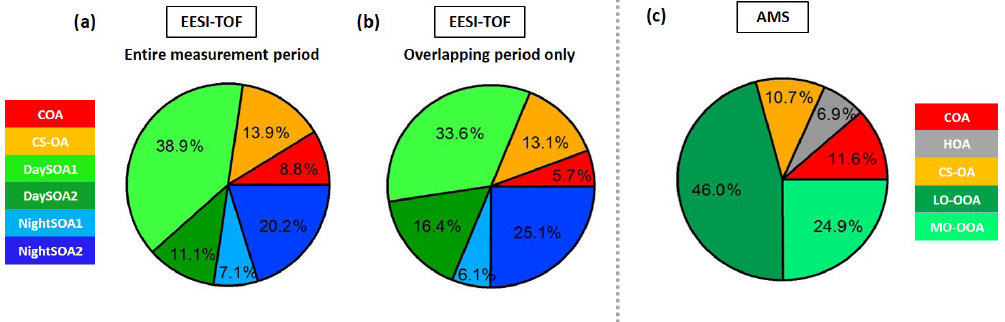
Figure 12. (a) Pie charts of the EESI-TOF-MS factor mean contributions (%) to the total measured signal for (a) the entire measurement period and (b) the period overlapping with the AMS measurements; (c) the AMS factor mean contributions (%) to the total measured organic mass.